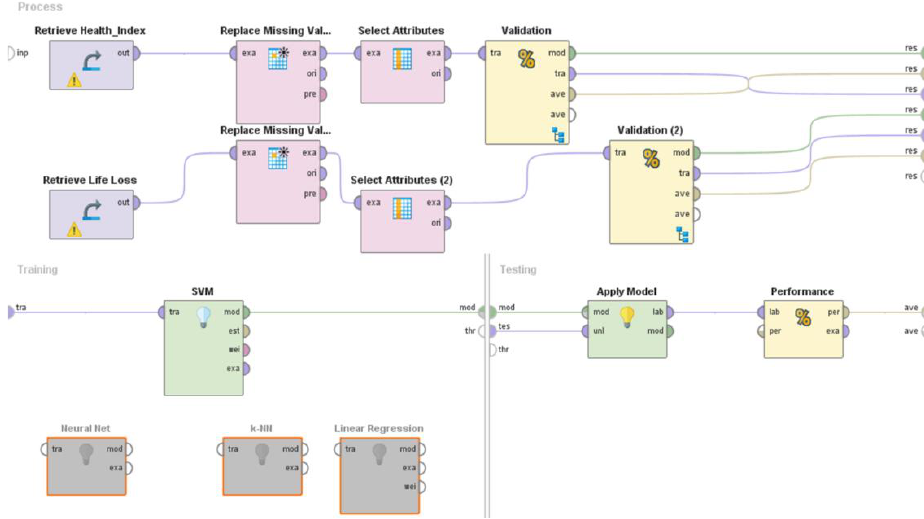
Figure 8. Regression comparative on RapidMiner.